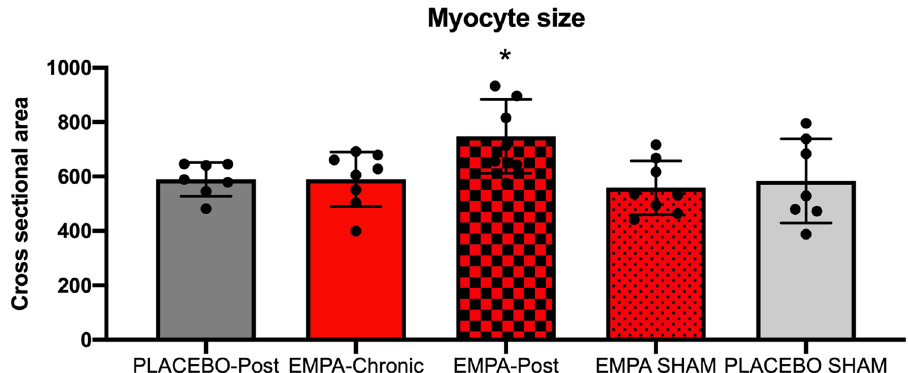
Figure 7. Myocyte cross sectional area. Histological analysis of Myocyte cross sectional area. PLACEBO-Post (n = 7), EMPA-Chronic (n = 7–8), EMPA-Post (n = 7), PLACEBO SHAM (n = 6–7) and EMPA SHAM (n = 8). Mean ± SD. Statistical significance is shown as * p < 0.05, **p < 0.01 vs.